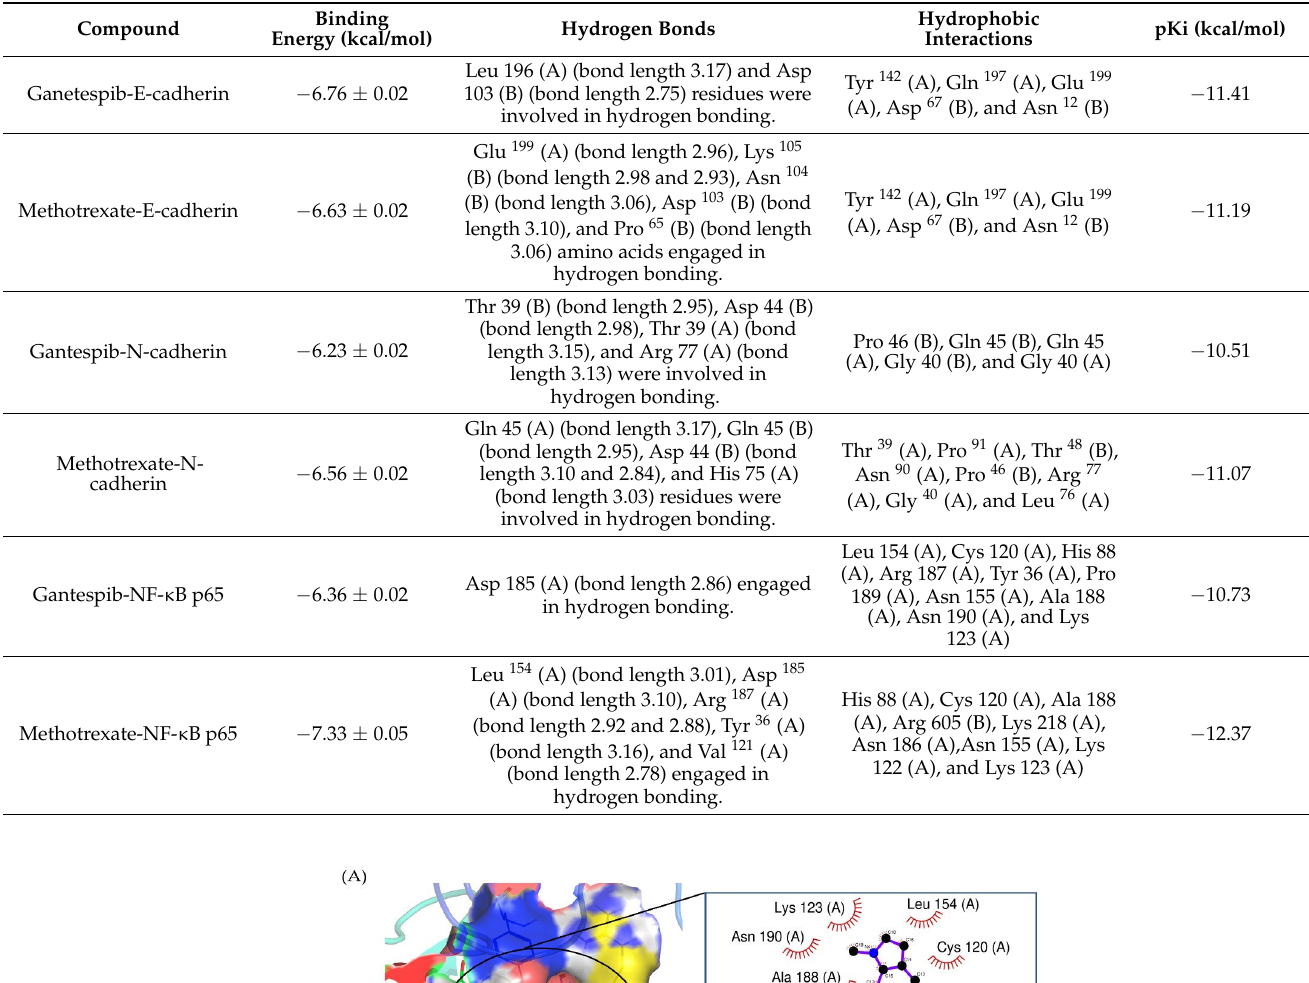
Table 1. Binding energies of GAN and MTX with lung cancer targets (E-cadherin, N-cadherin, and NF- κ B p65) and the interacting amino acids.